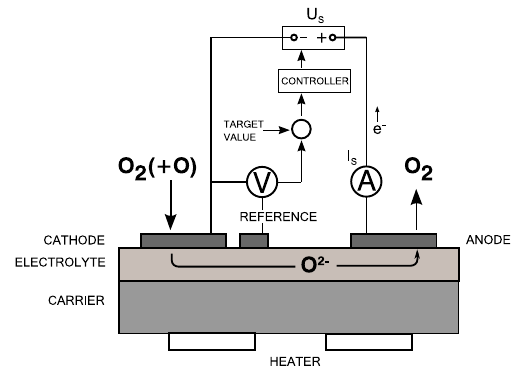
Figure 2. Electrical circuit of a sensor with three-electrode design and regulation of the reference voltage.